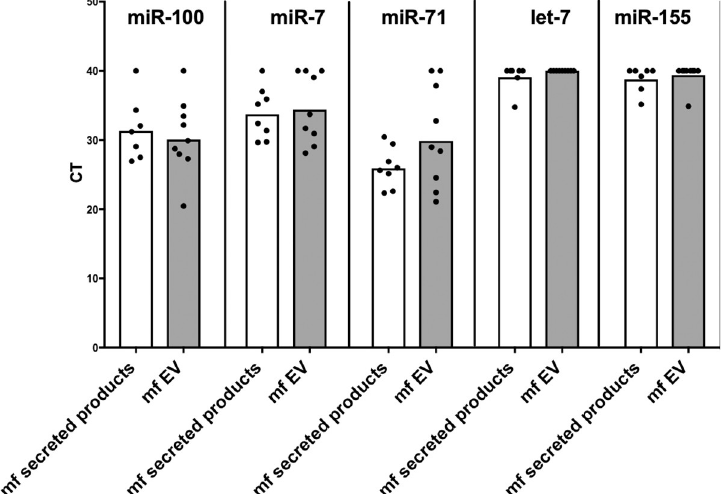
Fig 5. Presence of miRNAs predicted to target the mTOR pathway found in mf-derived EVs. cDNA was synthesized from small RNA that was extracted from mf-derived EVs. RT-PCR was then performed in order to screen EV nucleic acid cargo for miRNAs potentially targeting the mTOR pathway. The miRNA of interest included mir-100, mir-7, mir-71, let-7, and mir-155 as they are predicted to target genes relating to the mTOR pathway.